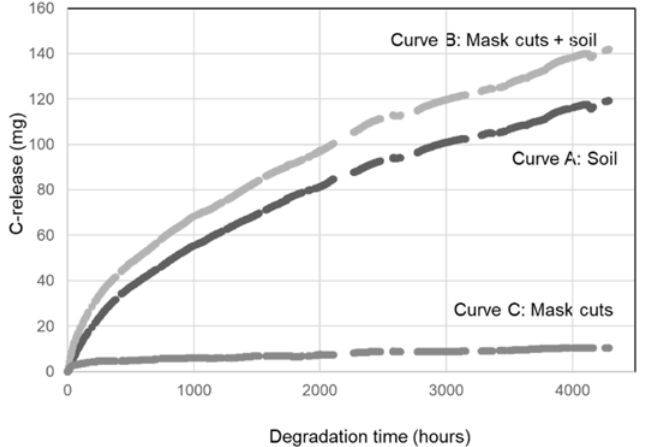
Figure 4. C released as CO 2 from a topsoil of a Cambisol incubated at a moisture of 75% of the maximal water holding capacity without (curve A) and with (curve B) addition of cuts from complete masks as a function of degradation time. Each point is the mean of four replicates. The C released only from the mask cuts (curve C) was obtained from the difference between curve A and B.